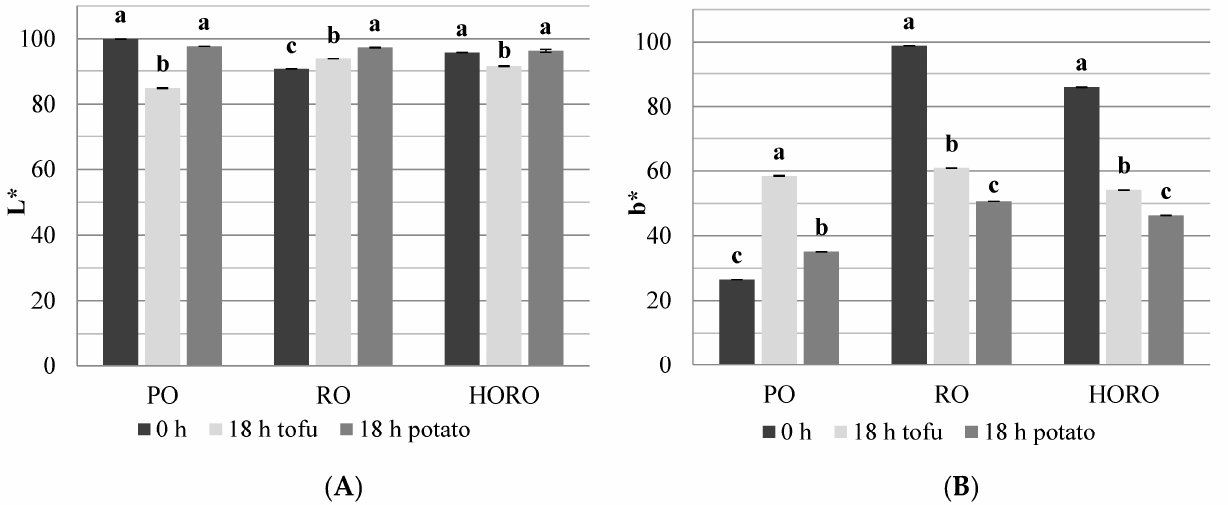
Figure 4. Changes in the color values L* ( A ) and b* ( B ) of tested oils during deep frying of potatoes or tofu. PO—palm olein; RO—cold pressed rapeseed oil; HORO—cold pressed high oleic rapeseed oil. The values for the specific oil with different letters (a, b, c) are significantly different ( p < 0.05).